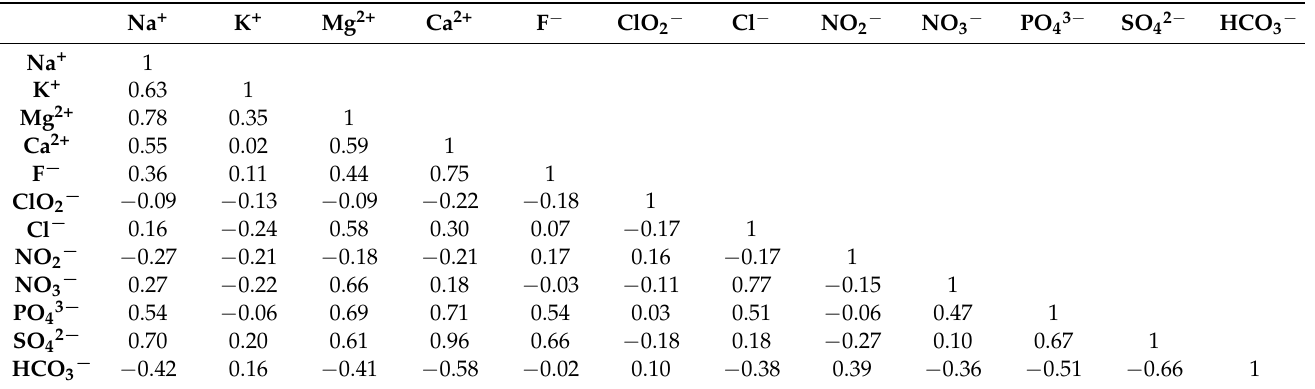
Table 3. Ion correlation analysis for brick